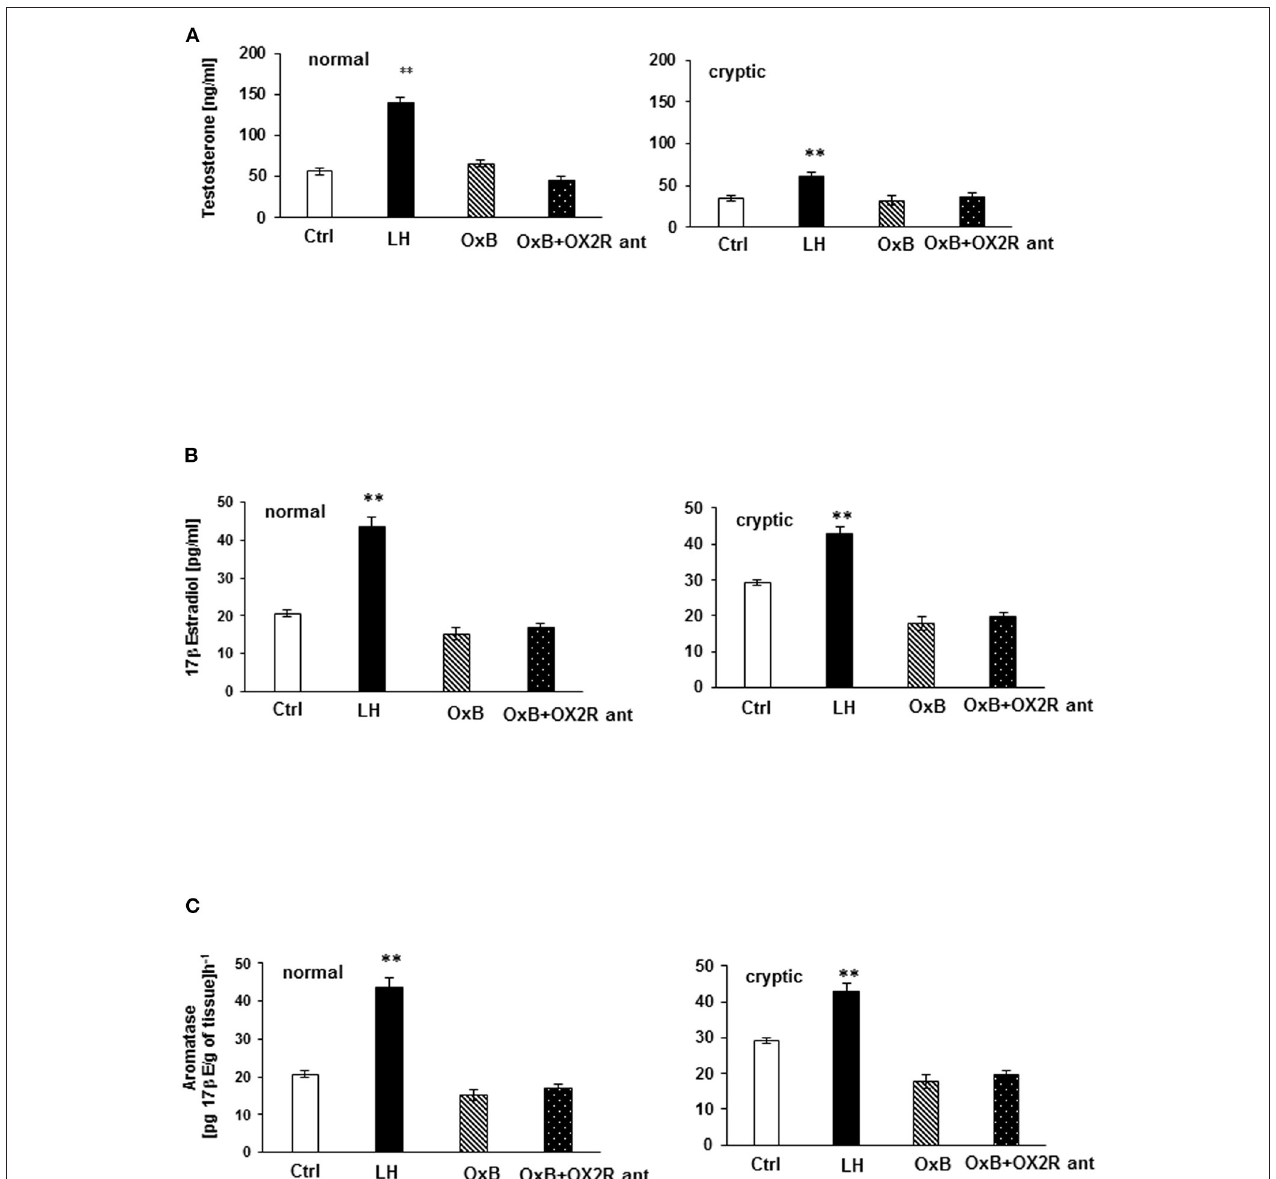
FIGURE 6 | In vitro testosterone (T) and 17 β Estrogen (17 β E) secretion (A,B) and aromatase (ARO) activity evaluation in normal and cryptorchid testis of dogs. (A) represents T secretion where data are presented in mean ± SD. ** P < 0.01 vs. corresponding controls. (B) represents 17 β E secretion, where data are expressed as the mean ± SD; n = 5; * p < 0.05, ** p < 0.01 vs. corresponding controls. (C) represents ARO activity values are expressed as 17 β -estradiol product per gram of tissue per hour. Data are presented as the mean ± SD. ** p < 0.01 vs. corresponding controls. All the experiments were conducted after 24h incubation with